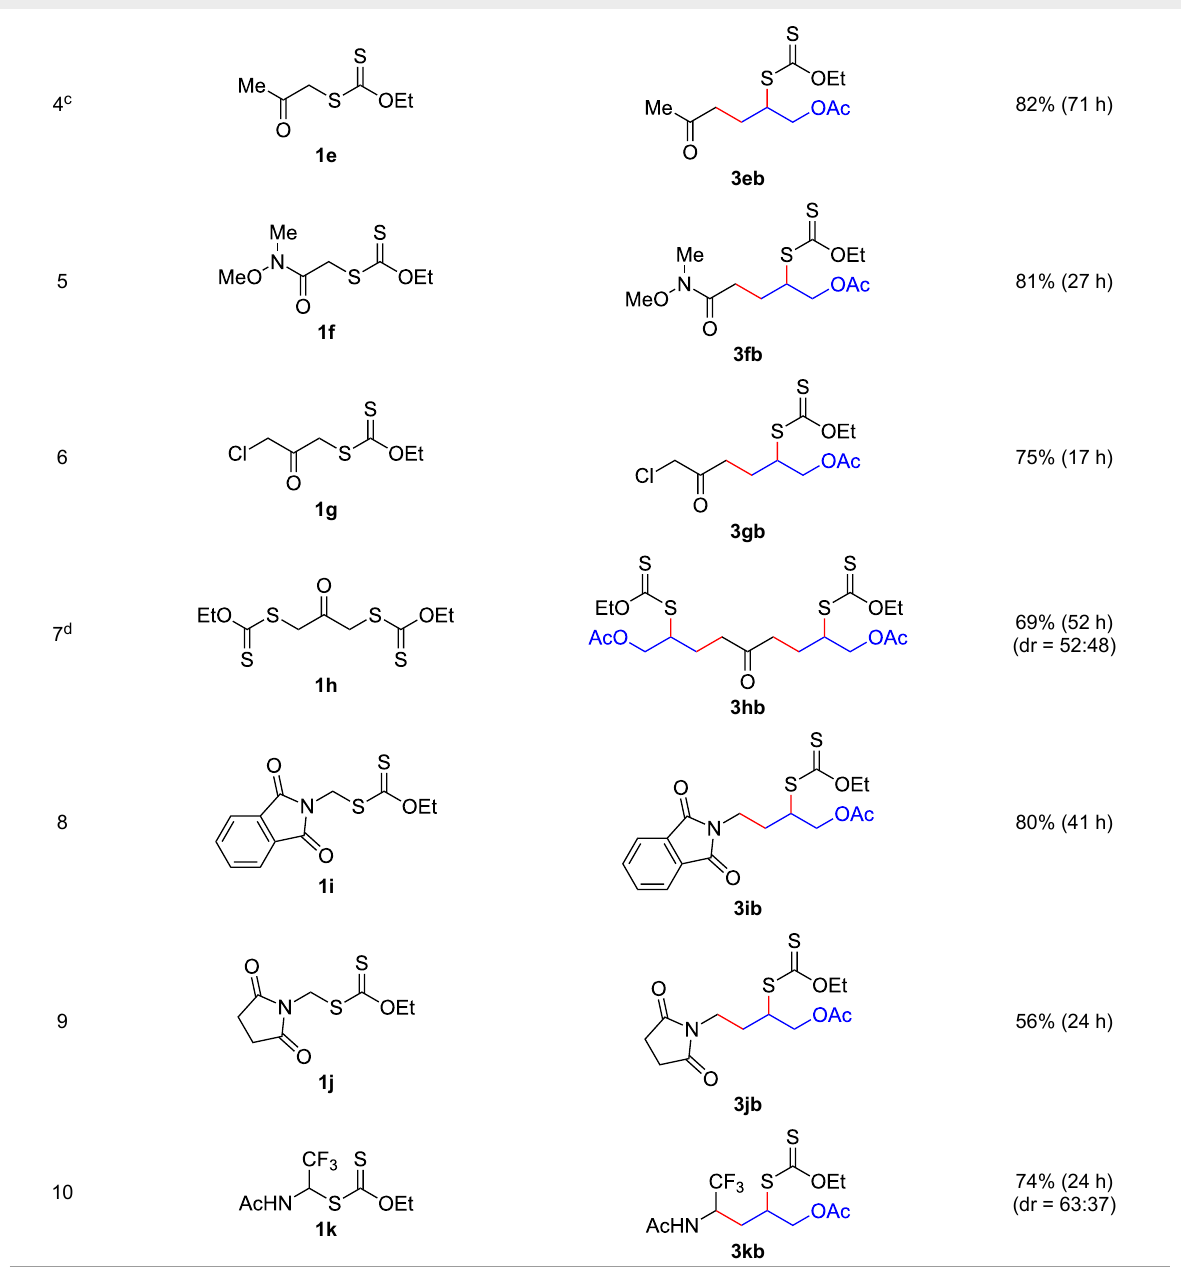
Table 3: Scope of xanthates. a